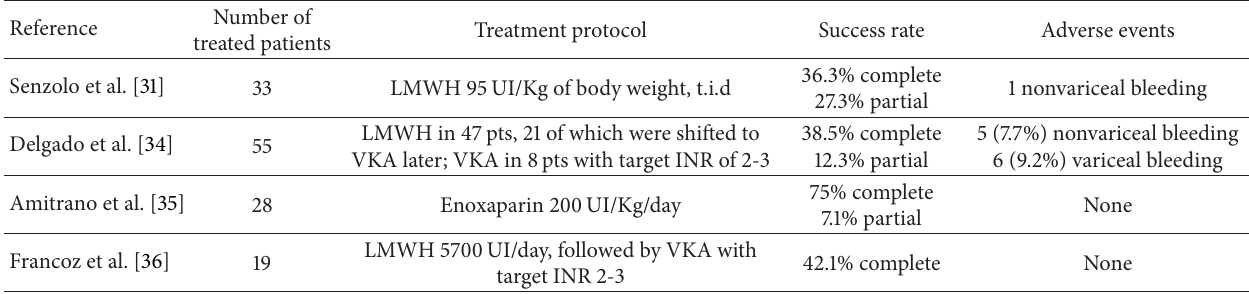
Table 1: Main studies published on anticoagulation therapy for PVT in cirrhotic